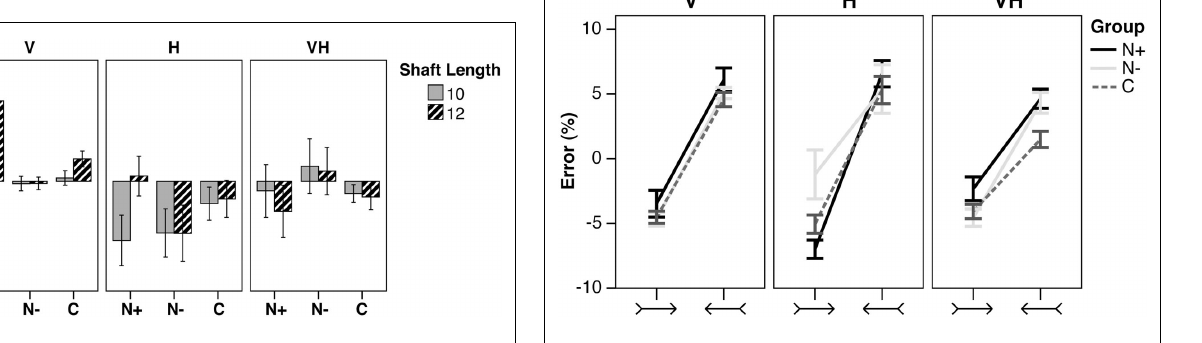
FIGURE 3 | Baseline errors. Mean percent error ( ± SEM) in shaft bisection in the baseline condition, by Shaft Length (10, 12cm), Group (N + /N − , patients with/without USN; C, neurologically unimpaired control participants), and presentation Modality (Visual,V; Haptic, H,Visuo-Haptic, VH). Negative/positive score: leftward/rightward error.